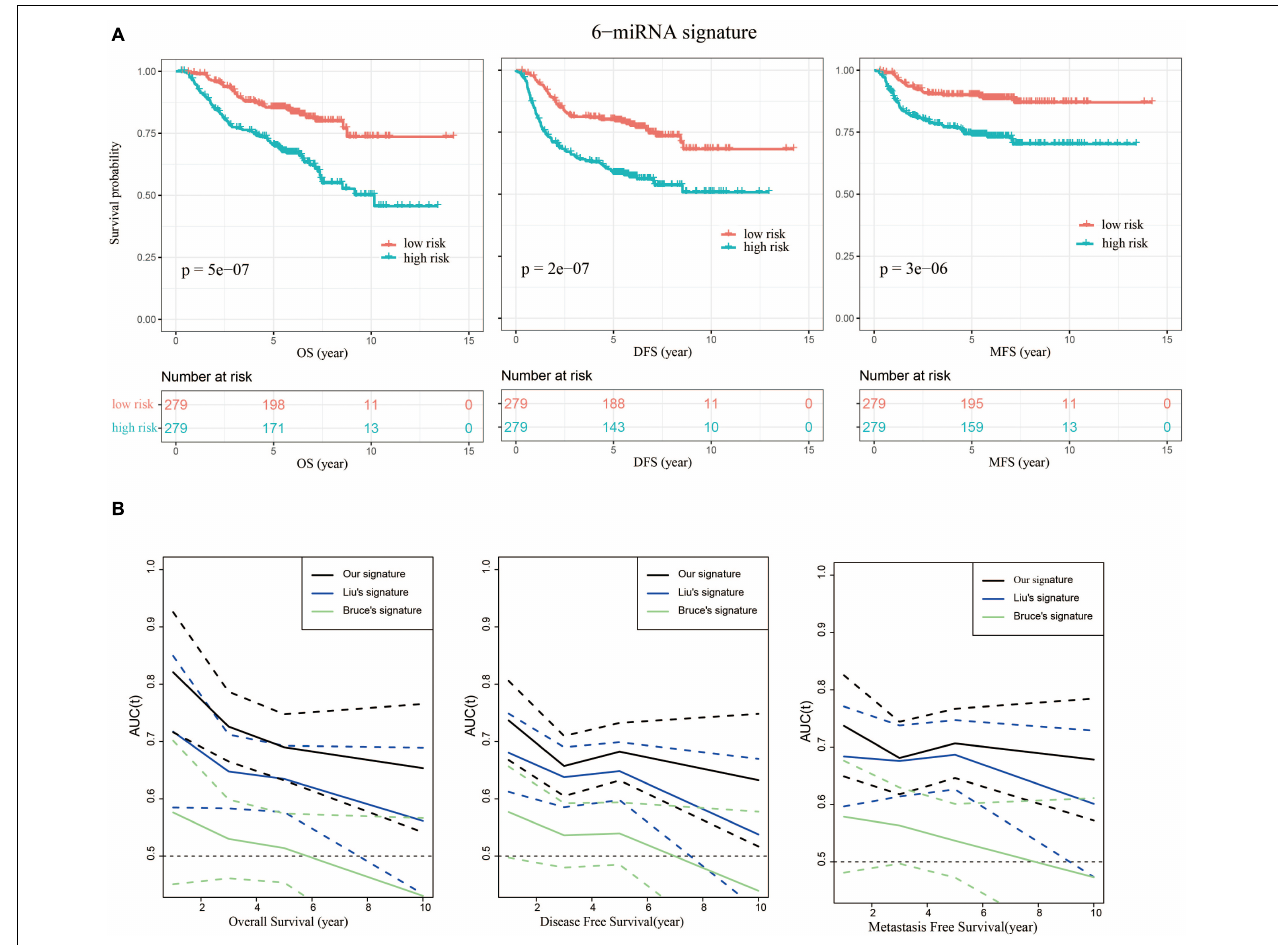
FIGURE 4 | Our 6-miRNA signature could predict OS, DFS, and MFS. (A) Kaplan–Meier graphs depicting overall survival (OS), disease-free survival (DFS), and metastasis-free survival (MFS) using the training dataset stratified by the 6-miRNA risk score, and p -values were based on log-rank test. (B) Comparison of the AUCs using our signature and the signatures of Liu and Bruce to predict OS, DFS, and MFS. The dashed lines represent the corresponding 95% confidence intervals of AUC by each model.